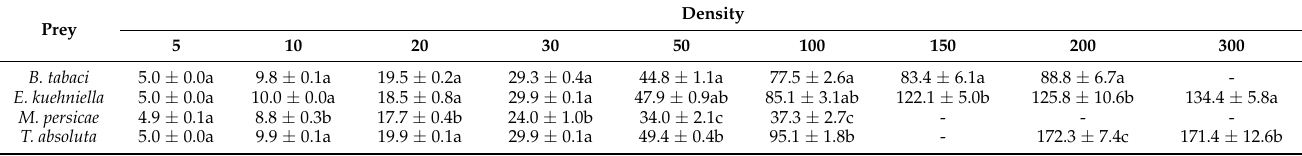
Table 3. Number (mean ± standard error) of prey ( Bemisia tabaci 4th instar nymphs, Ephestia kuehniella eggs, Myzus persicae 1st instar nymphs or Tuta absoluta eggs) consumed by Dicyphus cerastii females at each density in 24 h *.